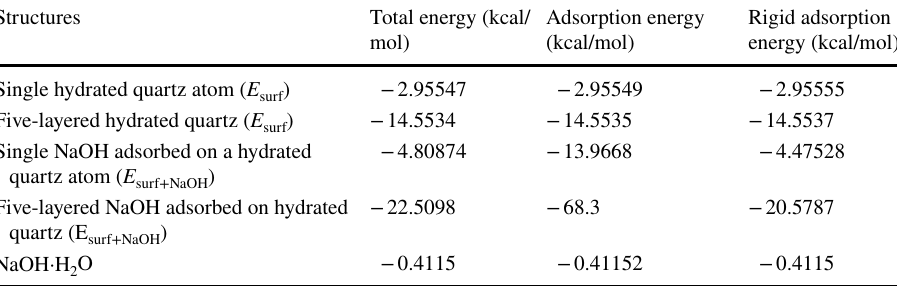
Table 1 Adsorption energy for the different simulated structures